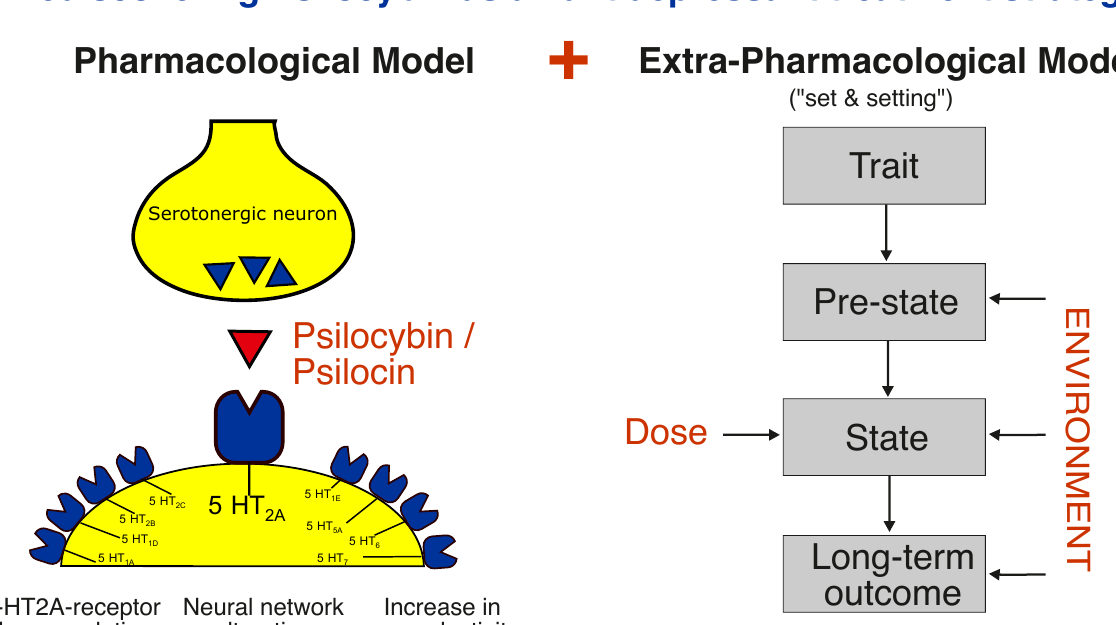
Figure 1. Mechanisms of action of psilocybin: A pharmacological and extra-pharmacological model. Extra-pharmacological model reprinted from ref.